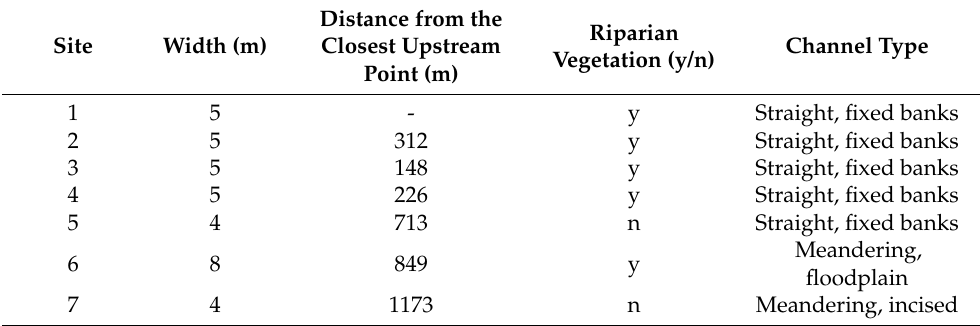
Table 2. Description of the sampling sites. Refer to Figure 1 for the geographic position of the sampling